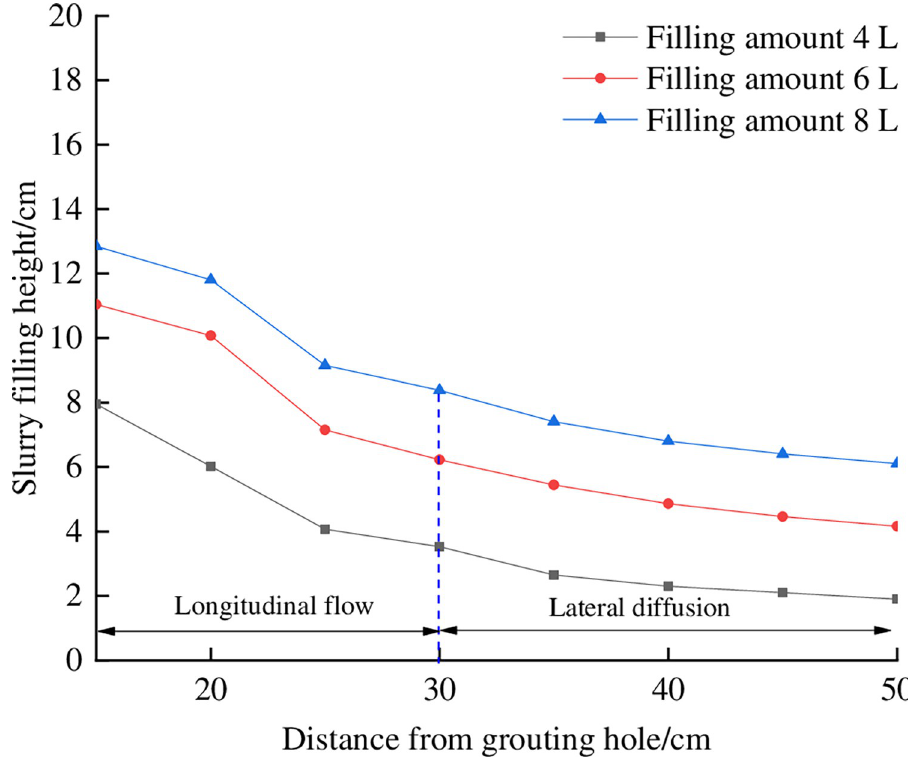
Fig 9. Curve of gangue slurry stacking